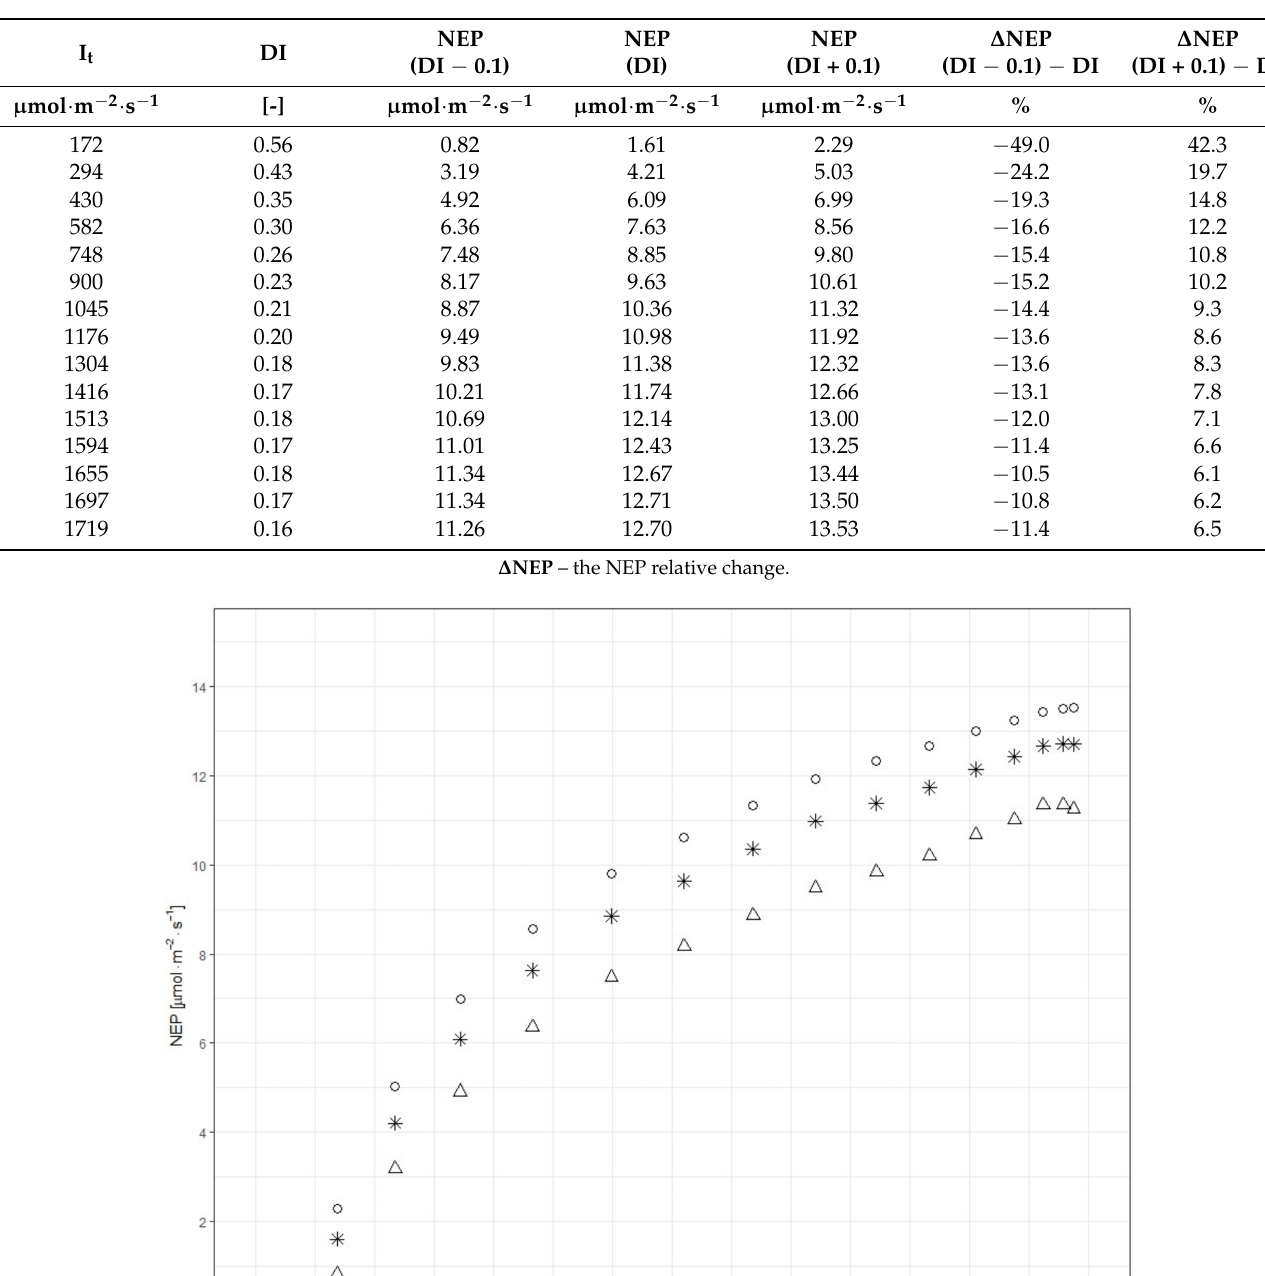
Table 2. Net ecosystem production (NEP) under different values of diffusion index (DI) and total photosynthetic photon flux density (I t ).